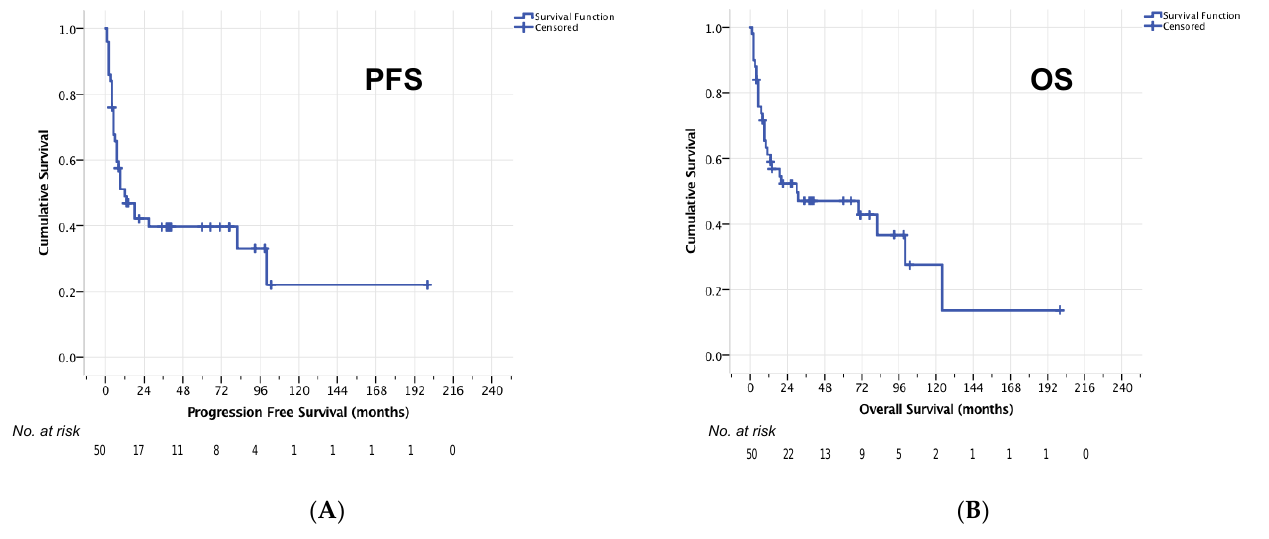
Figure 3. PFS ( A ) and OS ( B ) in 50 patients who completed HCT-ASCT. Next, the following factors potentially influencing prognosis were evaluated for pa- tients who completed HCT-ASCT ( n = 50): age groups (≥65 vs. <65, ≥50 vs. <50, ≥70 vs. <70), relapsed vs. refractory PCNSL, responses to induction treatment (CR/PR vs SD/PD), general physical performance at relapse (KPS ≥ 80 vs. <80), PCNSL involvement of deep brain structures, gender, and comorbidity (Charlson score 0 vs. ≥1).